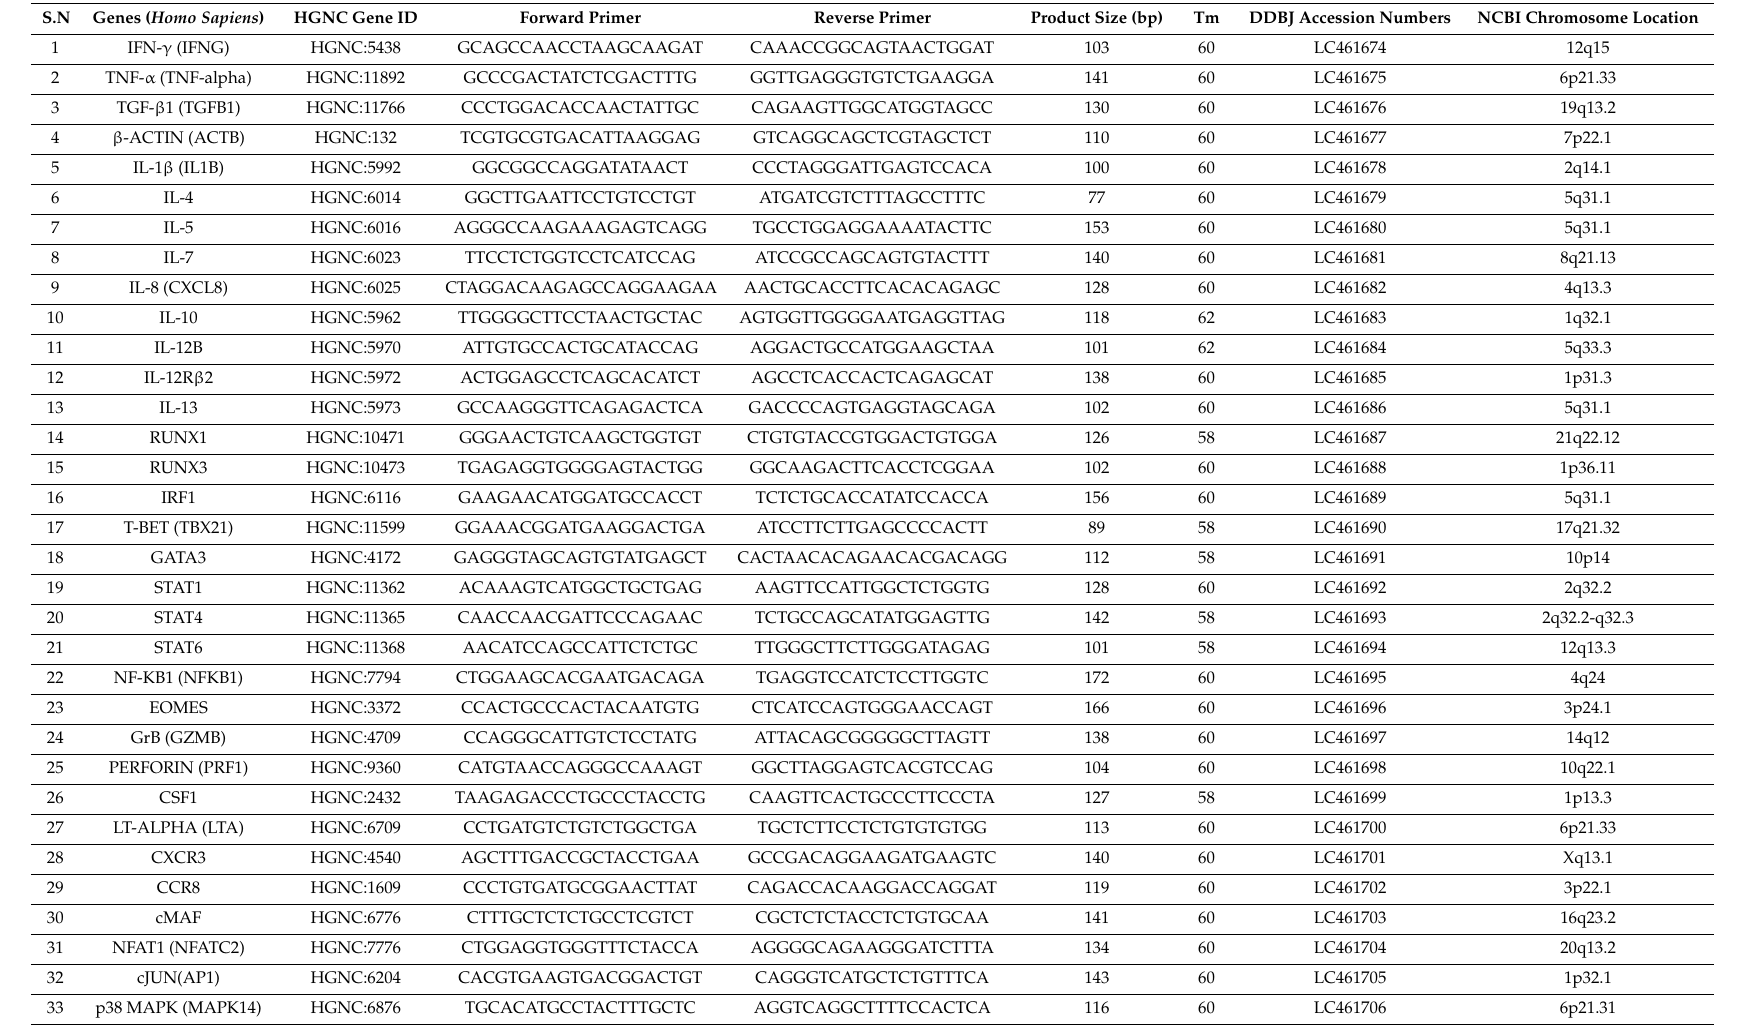
Table 2. List of primer sequences designed for SYBR green-based quantitative real-time polymerase chain